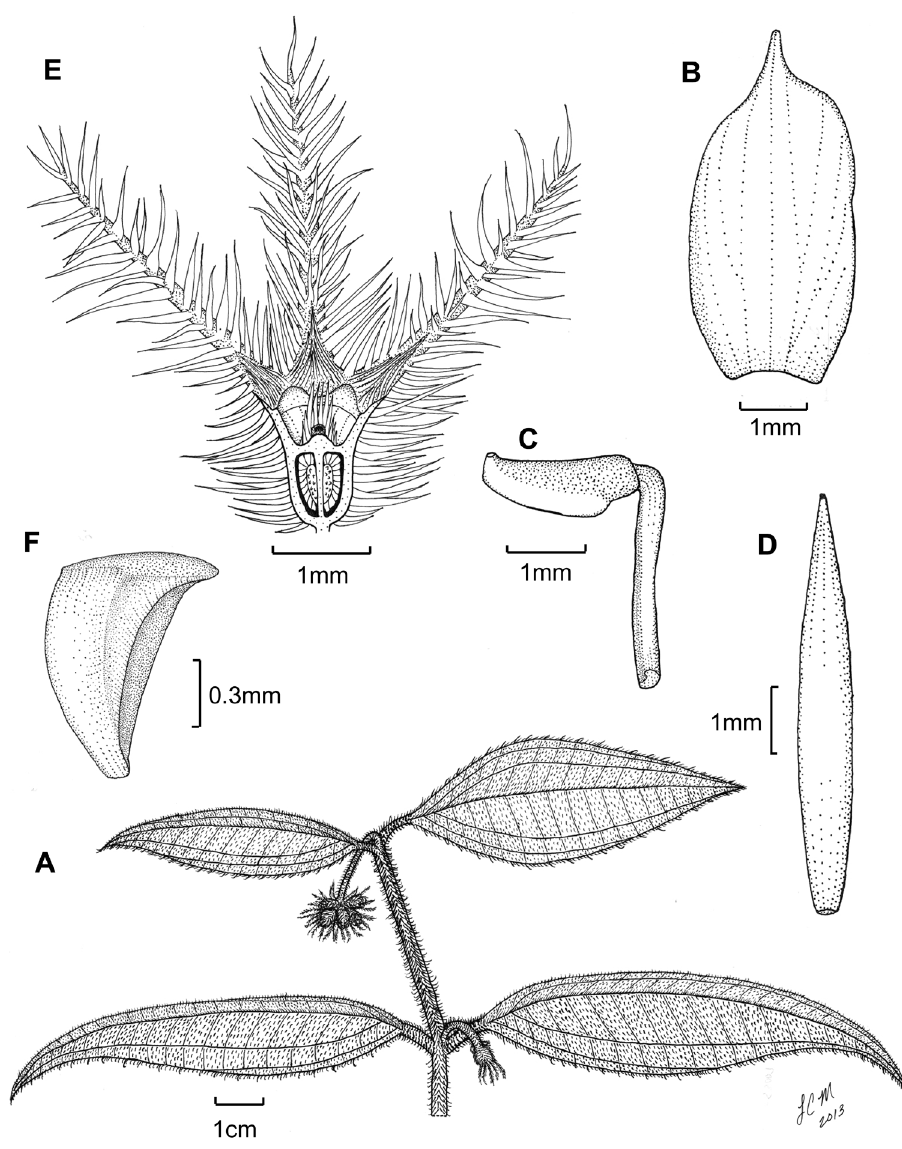
Figure 3. Illustration of Miconia jashaferi A habit ( Ekman 3849 ) B petal ( Alain 871 ) C stamen ( Alain 871 ) D style ( Alain 871 ) E immature fruit longitudinal section ( Alain 871 ) F seed ( Acuña SV-13275 ). Reproduced with permission from Majure et al.